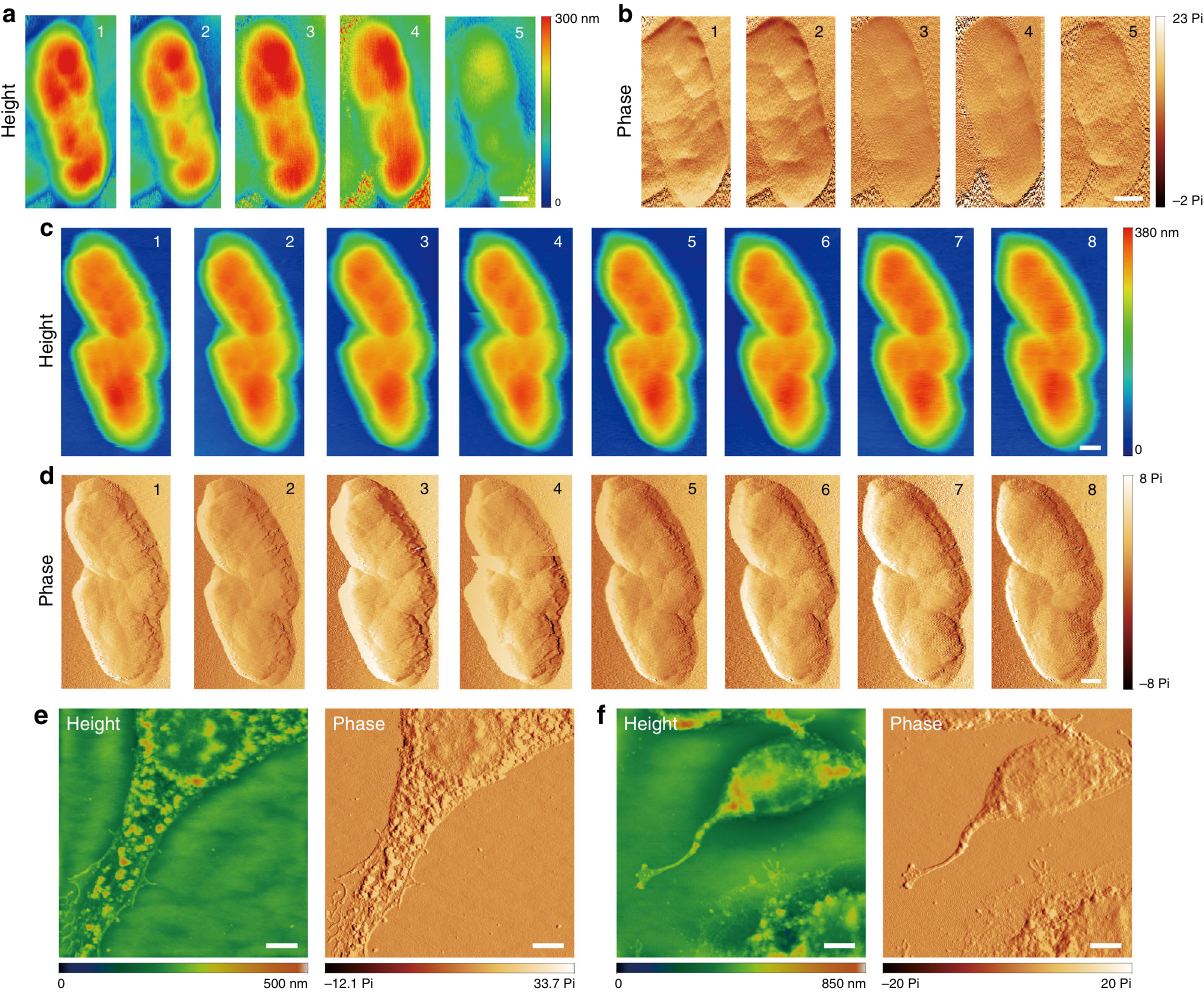
Fig. 5 AFM imaging of biosamples with RIE-etched CMA tip ( a = 5 μ m). a , b Height and phase pro fi les of Shewanella oneidensis MR-1 bacterial cells subjected to repetitive scans by a commercial tip. c , d Height and phase pro fi les of Shewanella oneidensis MR-1 bacterial cells after repetitive scans of an RIE- etched CMA tip ( a = 5 μ m) (Supplementary Fig. 20). The scanning times are marked at the top right corner of each fi gure. e , f AFM imaging of fi broblasts with the etched CMA tip ( a = 5 μ m). Scale bars are 400nm for a – d and 5 μ m for e , f